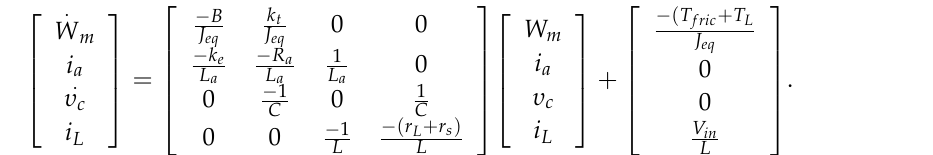
Figure 3. Electromechanical system with the switch ON.